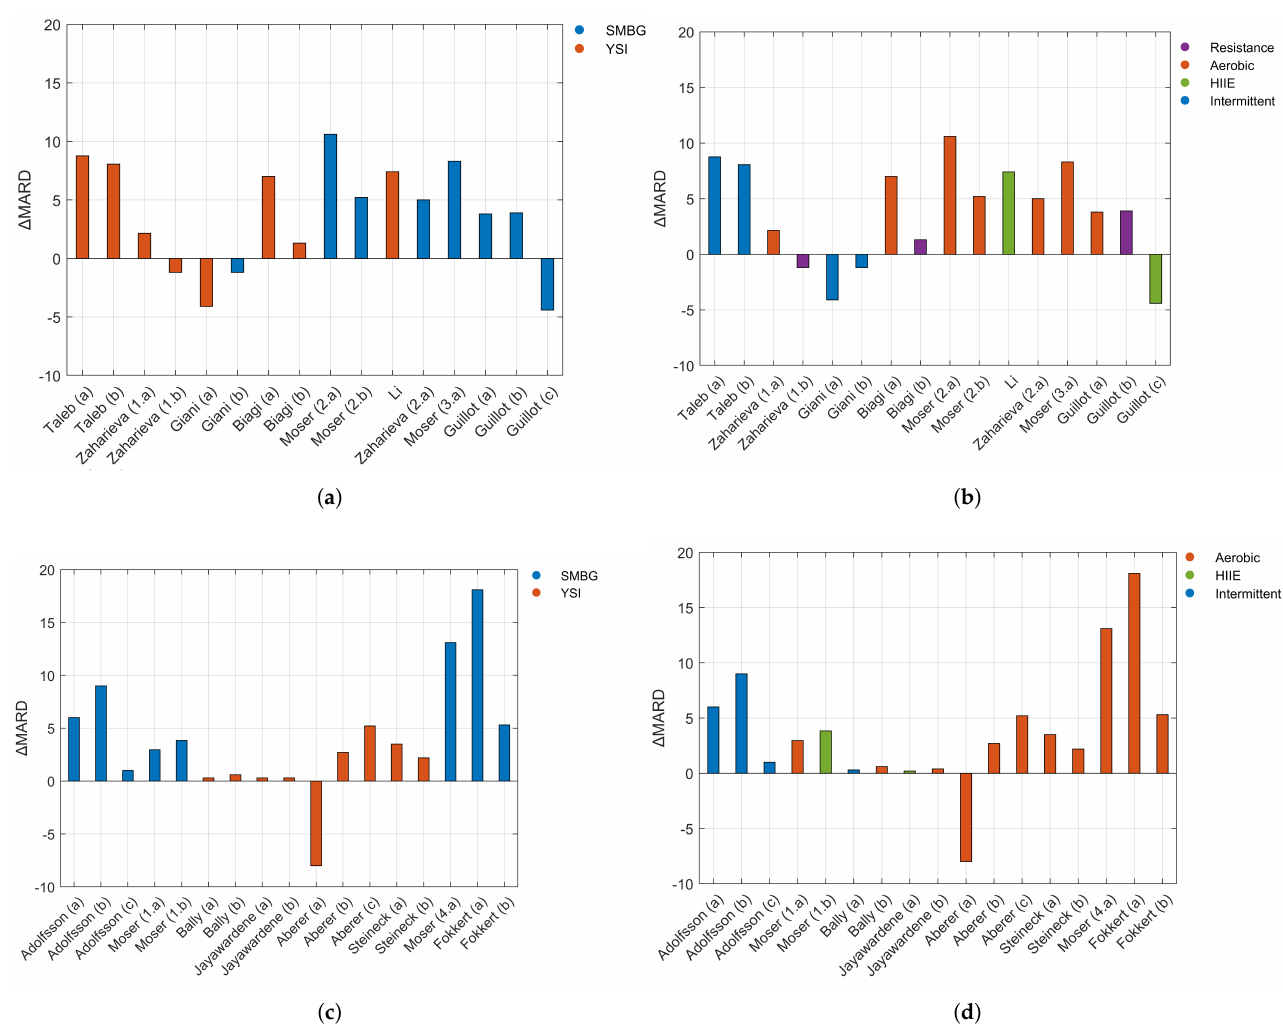
Figure 3. Panels ( a , b ) display data from studies that reported the MARD for both exercise and rest. Panel ( a ) shows ∆ MARD according to the reference used, and Panel ( b ) shows the same data coloured according to the type of exercise. Panels ( c , d ) display data from studies that reported MARD values for exercise periods, but did not provide MARD values for resting periods. In order to calculate ∆ MARD for those studies, MARD values for exercise were paired with the MARD from the sources in Table 2. Panel ( c ) displays ∆ MARD according to the reference used, and Panel ( d ) presents the same data coloured according to the type of exercise. In Panels ( a , c ), YSI stands for those studies that used gold-standard reference methods (YSI or equivalent) to calculate the CGM